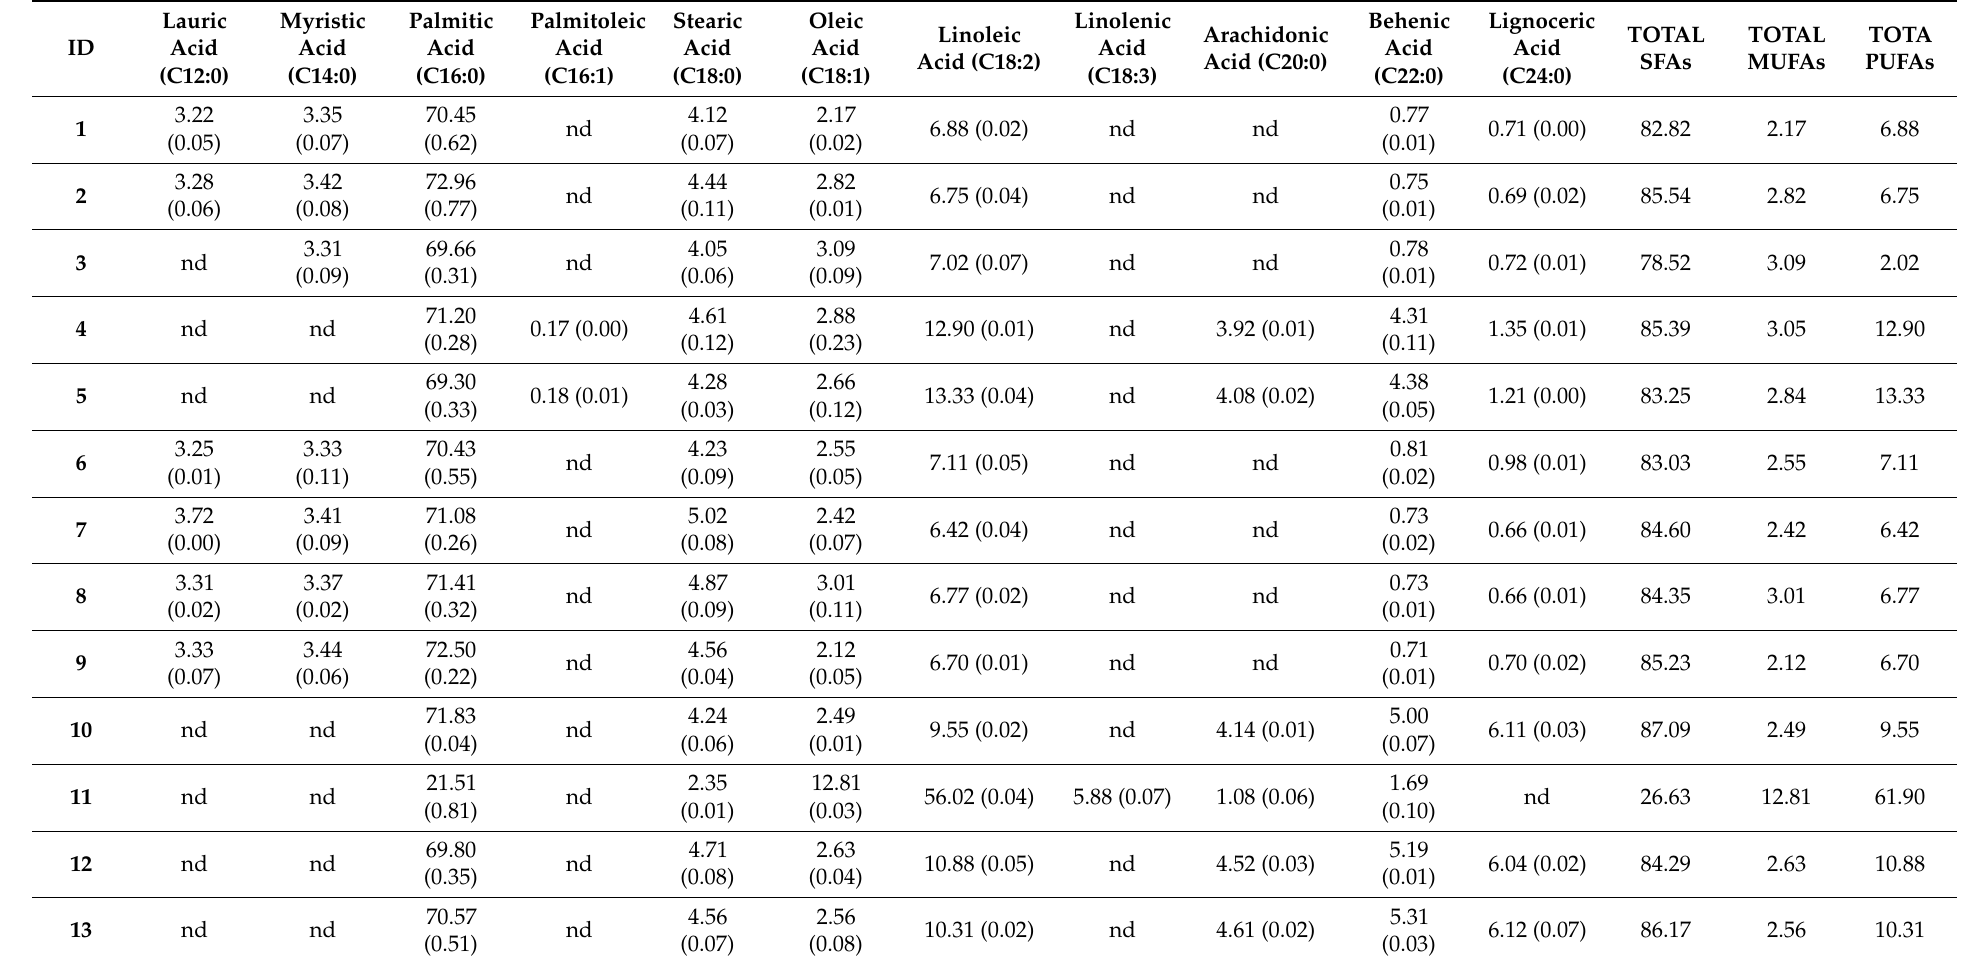
Table 7. Relative content of fatty acids (%) in S. patula by HPLC-values expressed as: mean (standard deviation, n − 1) n = 3. Legend: Lauric Acid (C12:0); Myristic acid (C14:0); Palmitic acid (C16:0); Palmitoleic acid (C16:1); Stearic acid (C18:0); Oleic acid (C18:1); Linoleic acid (C18:2); Linolenic acid (C18:3); Arachidonic acid (C20:0); Behenic acid (C22:0); Lignoceric